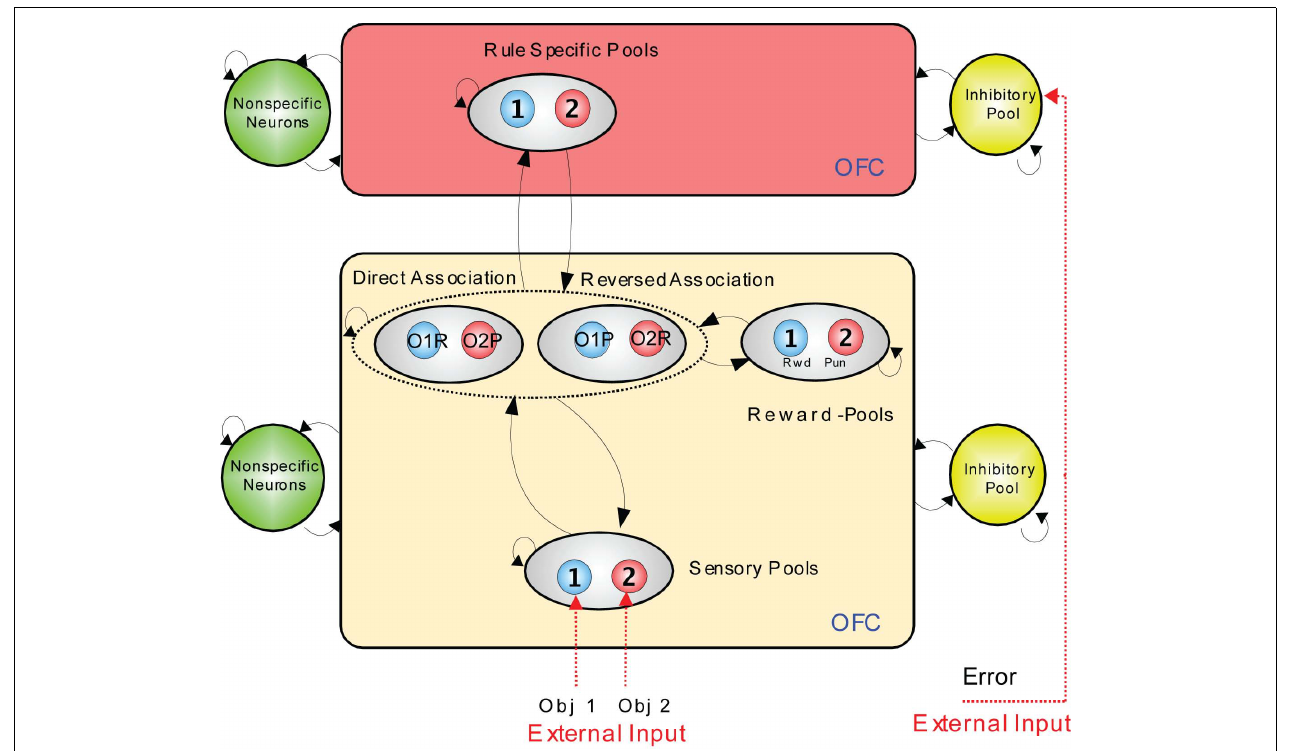
object and its association with (e.g., taste) reward or punishment, e.g., object1–reward (O1R, in the direct association set of pools), and object1–punishment (O1P in the reversed association set of pools).The rule module acts as a biasing input to bias the competition between the object–reward combination neurons at the intermediate level of the sensory – intermediate neuron – reward module.The model was implemented with integrate-and-fire neurons. OFC, orbitofrontal cortex. (After Deco and Rolls, 2005c).